Question: What type of chart is this?
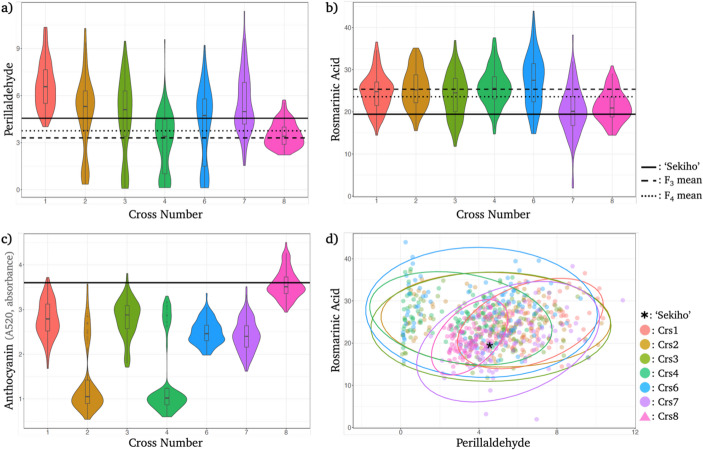
Answer: scatter